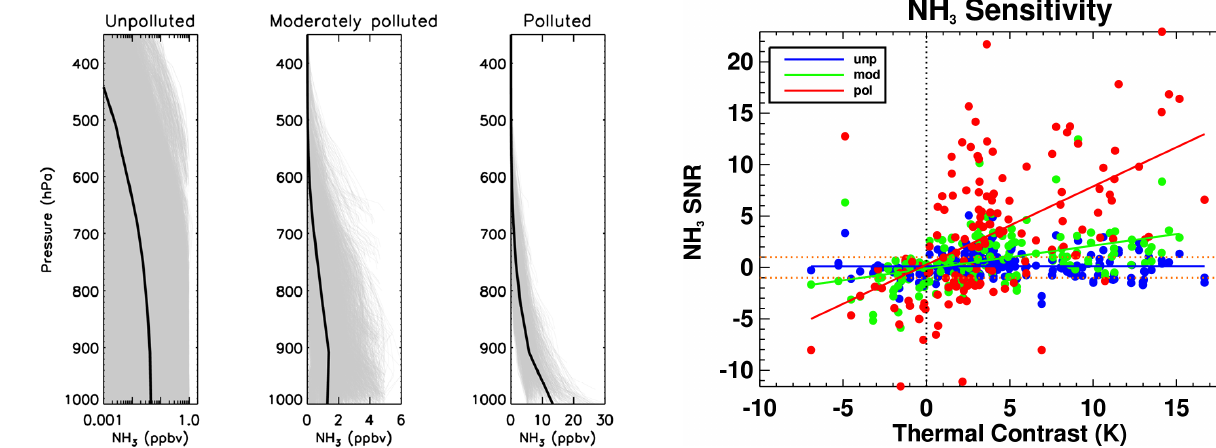
Fig. 5. Scatter plot of SNR over the TES NH 3 band versus the ther- mal contrast (surface temperature – air temperature at the bottom of the profile) for unpolluted (blue), moderately polluted (green), and polluted (red) NH 3 profiles. The straight lines are linear fits to the results for each profile type. The two horizontal dashes lines (yellow) correspond to the SNR of ± 1.